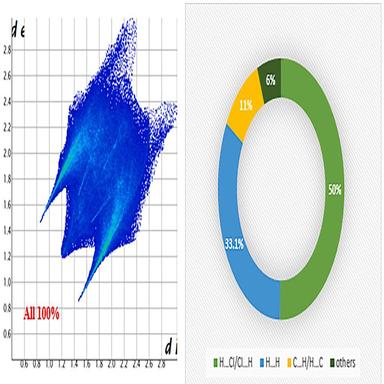
A Pie graphs displaying the percentage contributions of the various intermolecular contacts contributing to the Hirshfeld surfaces and Full 2D fingerprint plots of the all interactions in the title complex for (C8H12N)42.